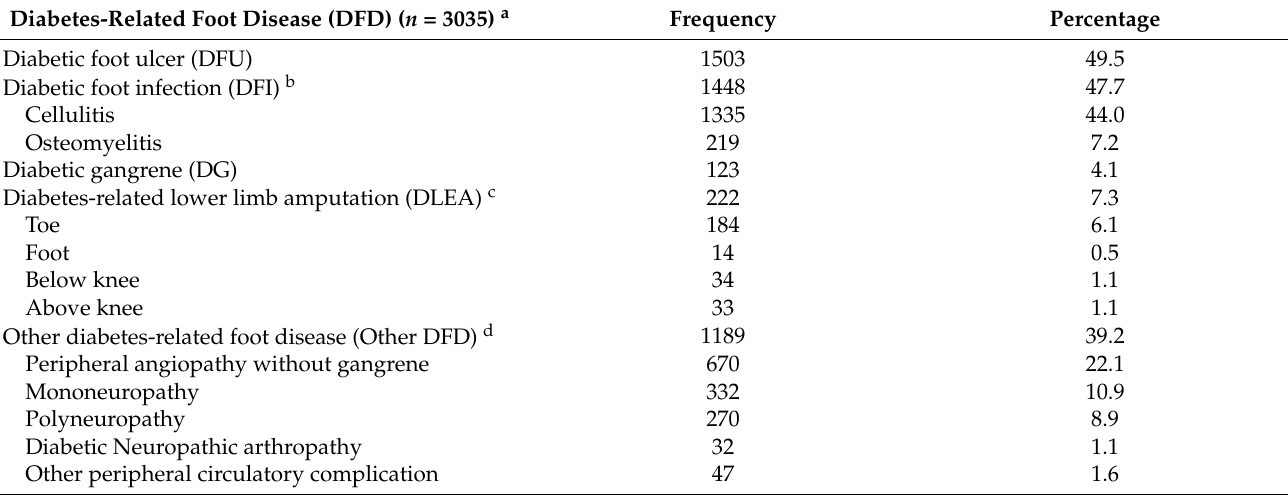
Table 1. Distribution of patients with diabetic foot complications ( n =